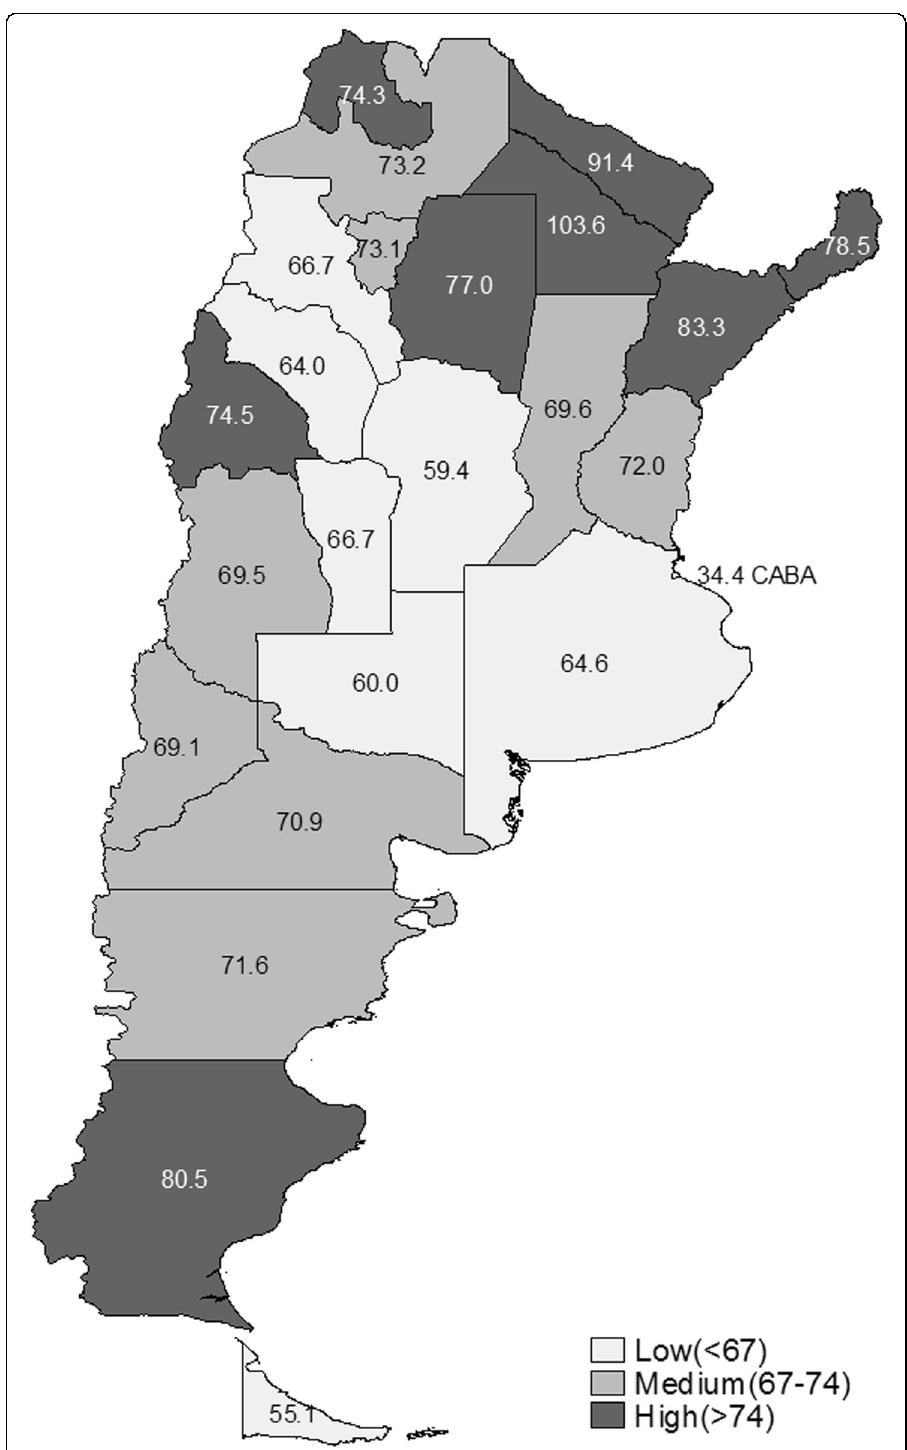
Fig. 2 Teenage fertility rates by province. Argentina, 2011 (number of live births per 1000 women aged